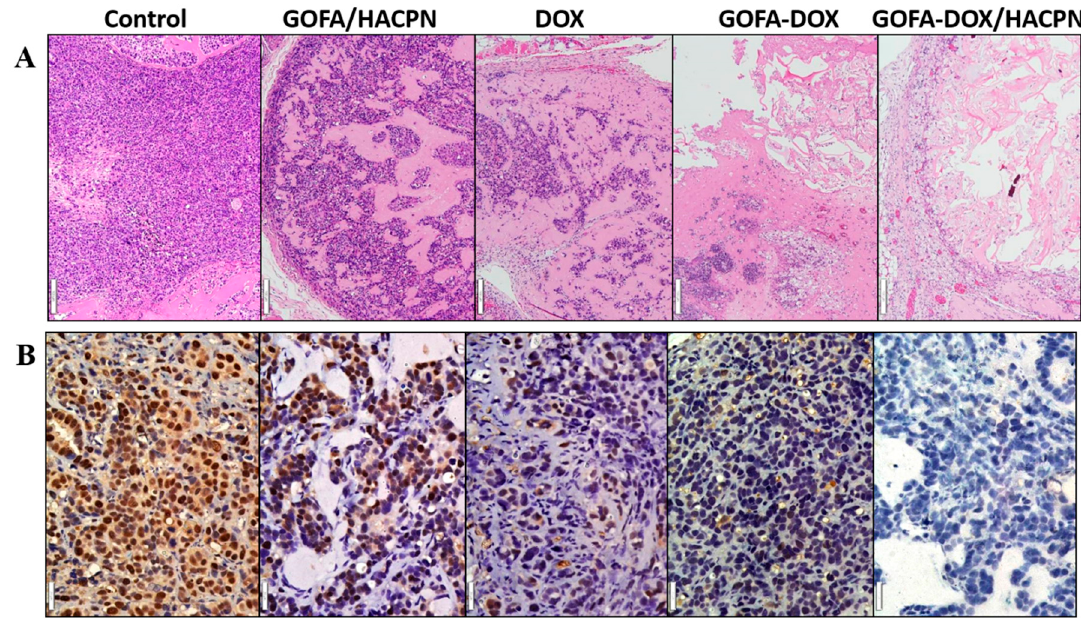
Figure 10. ( A ) H&E (Bar = 100 μ m) and ( B ) proliferating cell nuclear antigen (PCNA) immunohistochemical (Bar = 20 μ m) staining of retrieved tumor tissues at day 21. Improved tumor delivery of DOX should also inhibit proliferation of cancer cells.